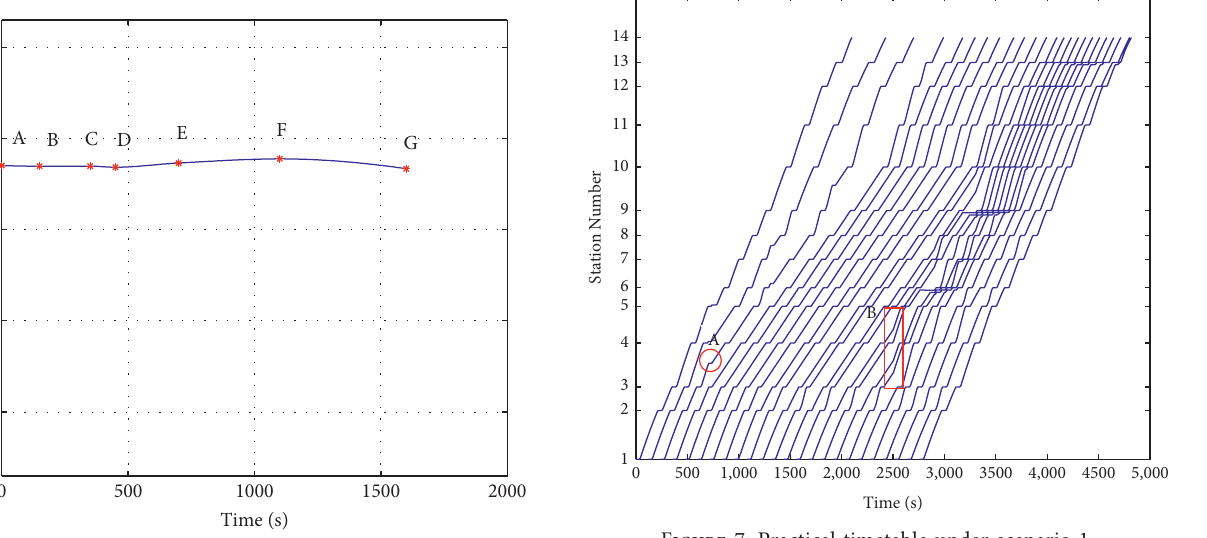
Figure 6: Network performance changes of the CBTC system under scenario 2.